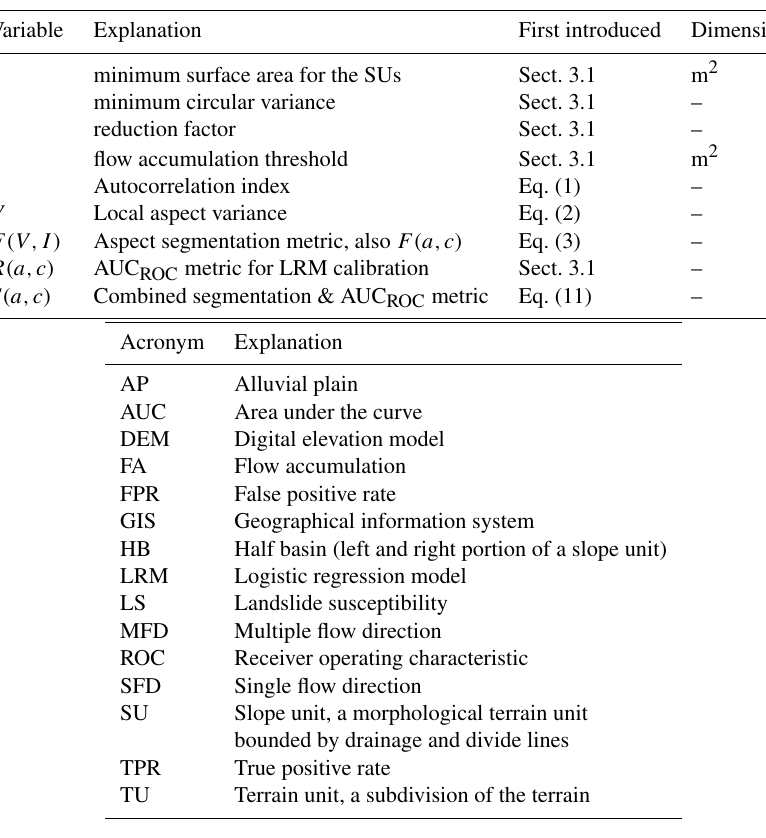
Table A1. Main variables and acronyms used in the